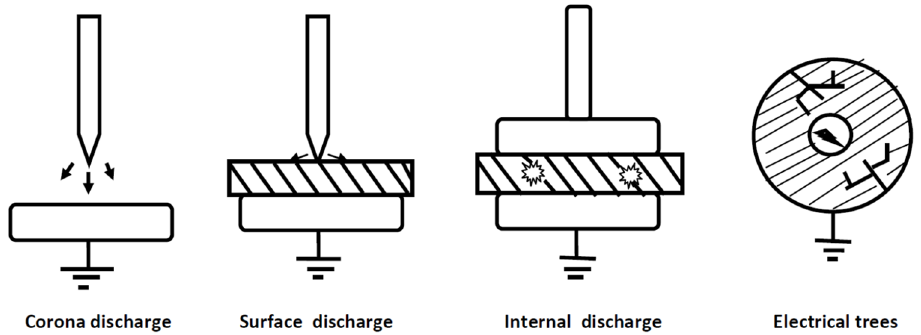
Figure 8. Types of Partial Discharge.